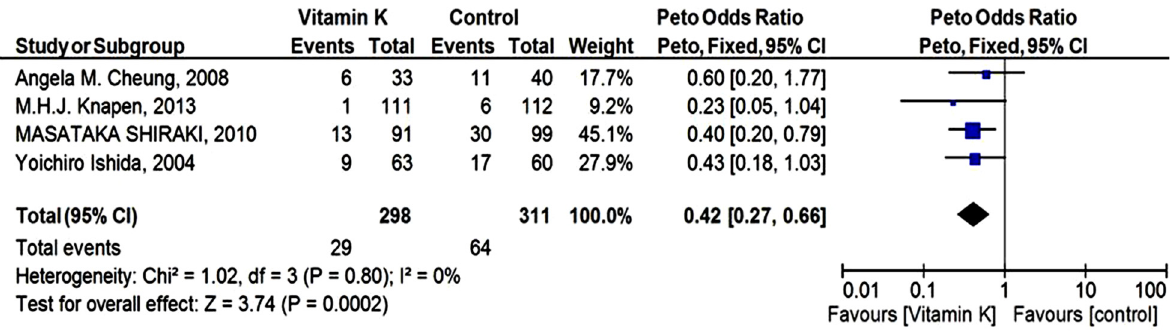
Figure 3. Forest Plot: Peto odds ratio for the effect of Vitamin K and placebo on vertebral fracture outcome.